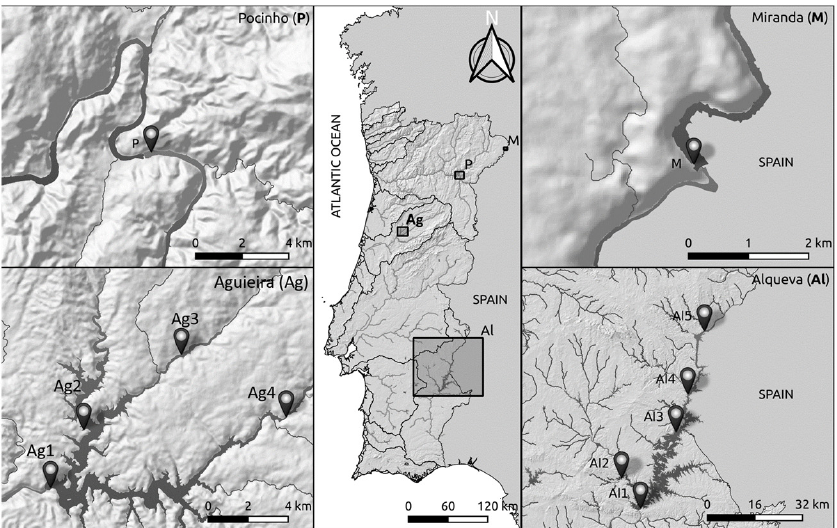
Figure 1. Location of the sampling sites in Miranda (M—41°29 ′ 24.802 ″ N, 6°15 ′ 55.925 ″ W), Pocinho